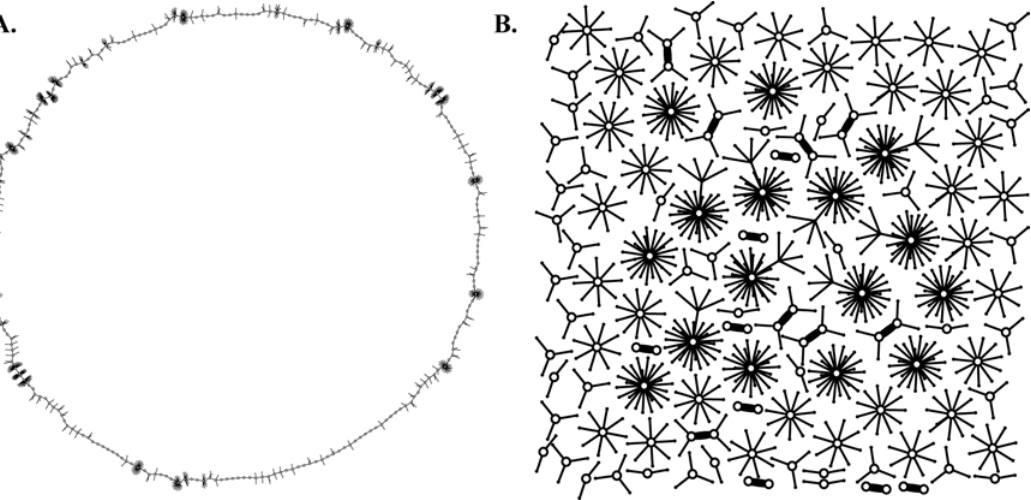
Figure 9. State spaces of evolved networks. (A) State space of a network evolved in a population of 100 networks after 100 generations of selection for large attractor size. The attractor shown has length 254. Here N =10, l =3, and p =0.5. (B) State space of a network evolved under selection for many attractors. This network has 112 attractors. All other parameter values as in (A).